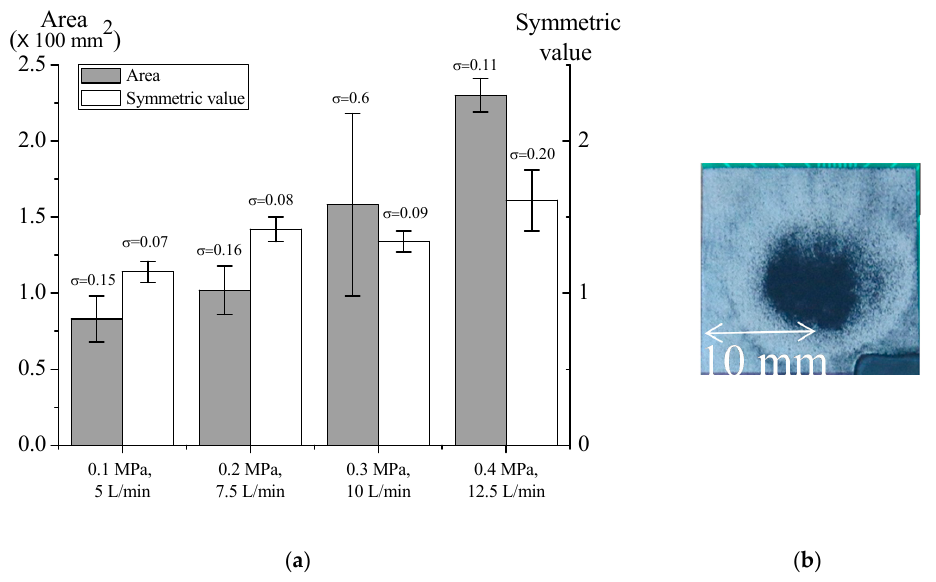
Figure 5. ( a ) Effects of pressure and flow rate on particle deposition with 60 ‐ mm nozzle. Data are shown with mean ± SD ( n = 3); and ( b ) Ring vortex.